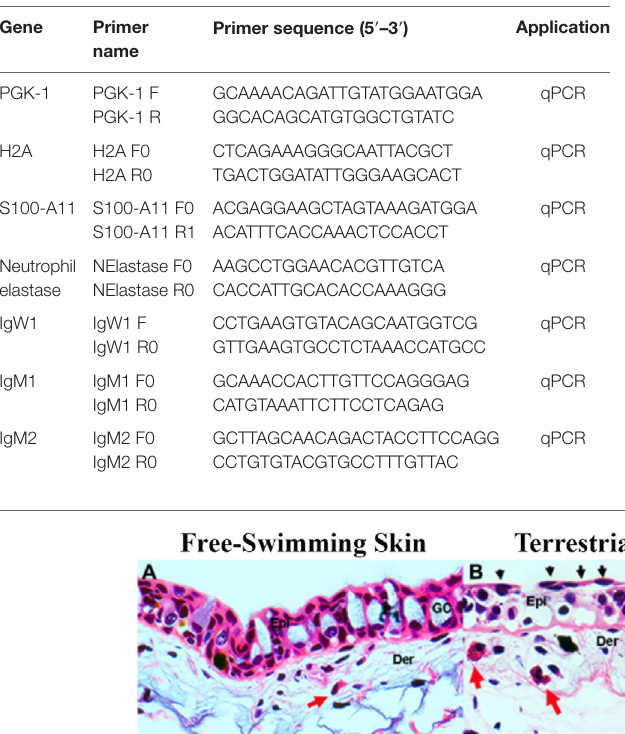
Table 1 | Primers used in this study.